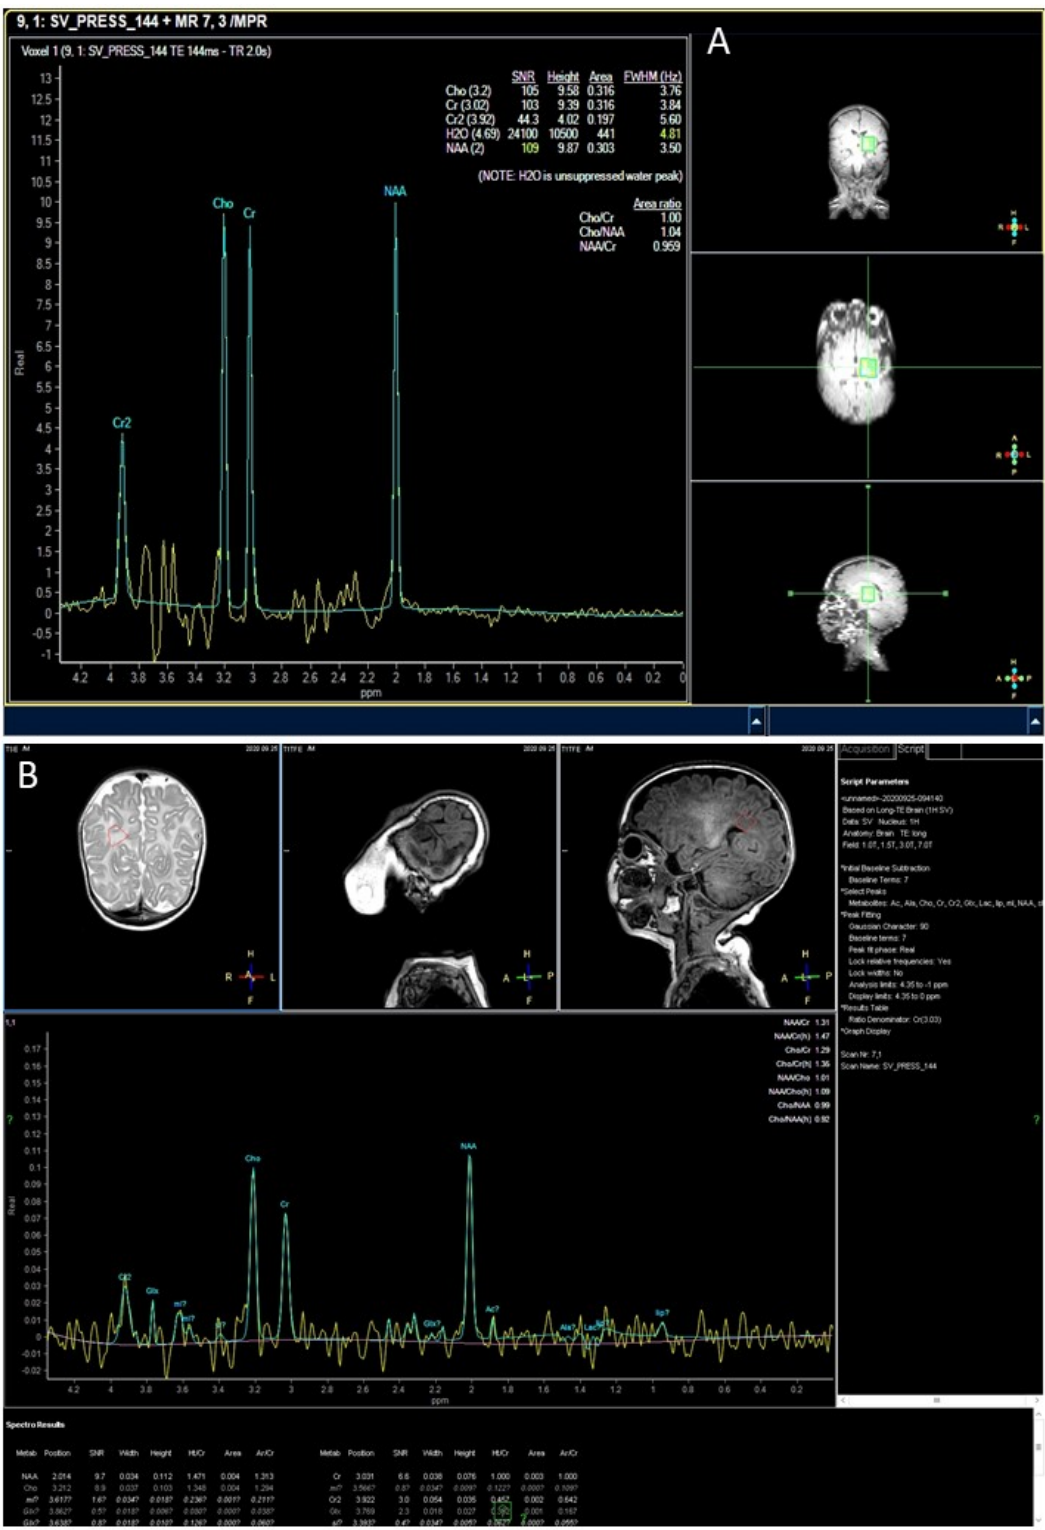
Figure 2. MR Spectroscopy of Patients 2 and 4. MR spectroscopy of Patient 2 showing almost equally high peaks of choline, creatine, and N-acetyl-aspartate, characteristic of leukoencephalopathy and hypomyelination ( A ). Near-normal MR spectrogram in a less advanced stage of patient 4 ( B ).